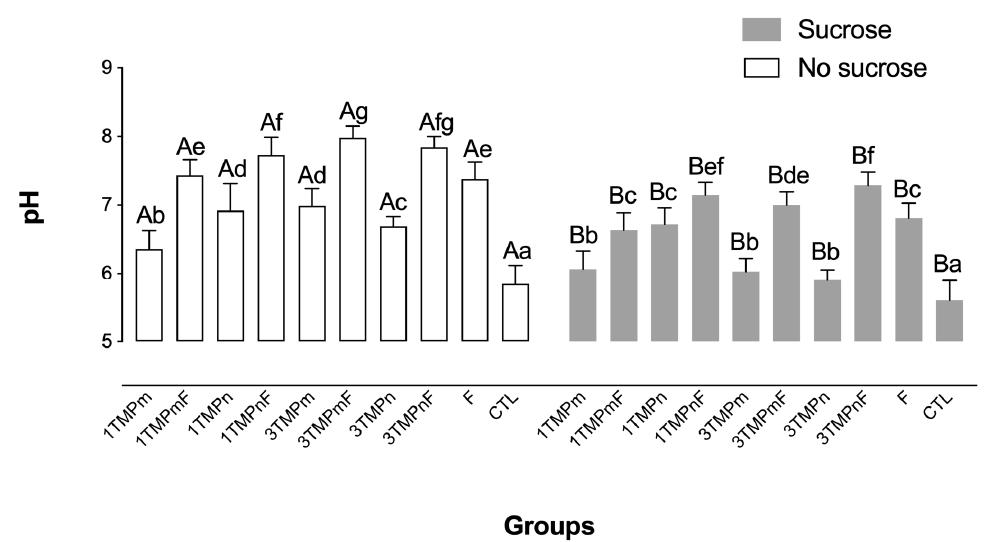
Figure 4. Mean pH values prior to and after exposure to sucrose (cariogenic challenge). Distinct upper ‐ case letters indicate statistical differences within each group regarding exposure to a 20% sucrose solution (in two levels – yes or no). Distinct lower ‐ case letters indicate statistical differences among the experimental groups (all test solutions) within each condition of sucrose exposure). Data were submitted to 2 ‐ way ANOVA, followed by Fisher ʹ s LSD post hoc test for multiple comparisons ( p < 0.05). Bars denote standard deviations of the means. The experiments were performed in triplicate, in three different moments ( n =9). TMPm: micro ‐ sized sodium trimetaphosphate; TMPn: nano ‐ sized sodium trimetaphosphate; CTL: negative control.